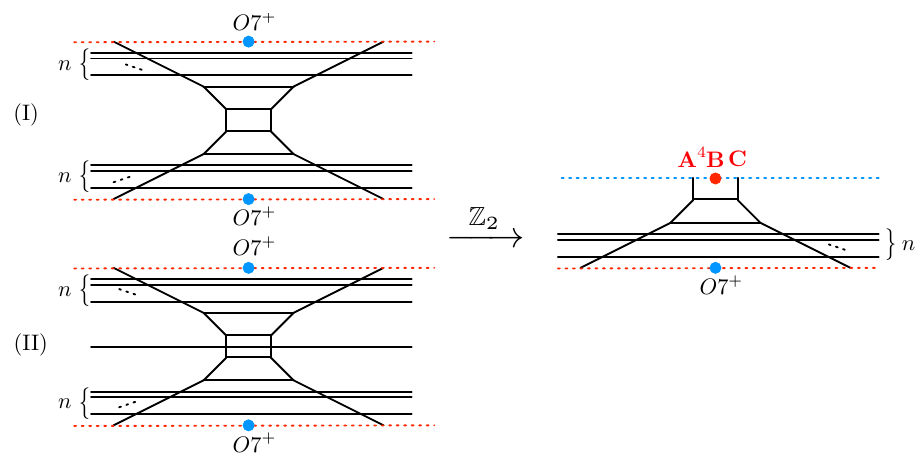
Figure 32 . The Z 2 quotient of 6d SO(2 N + 8) + 2 N F theory leading to 5d SO(2[ N/ 2] + 6) + (2[ N/ 2] + 4) F . Here, (I) is for N = 2 n and (II) is for N = 2 n + 1